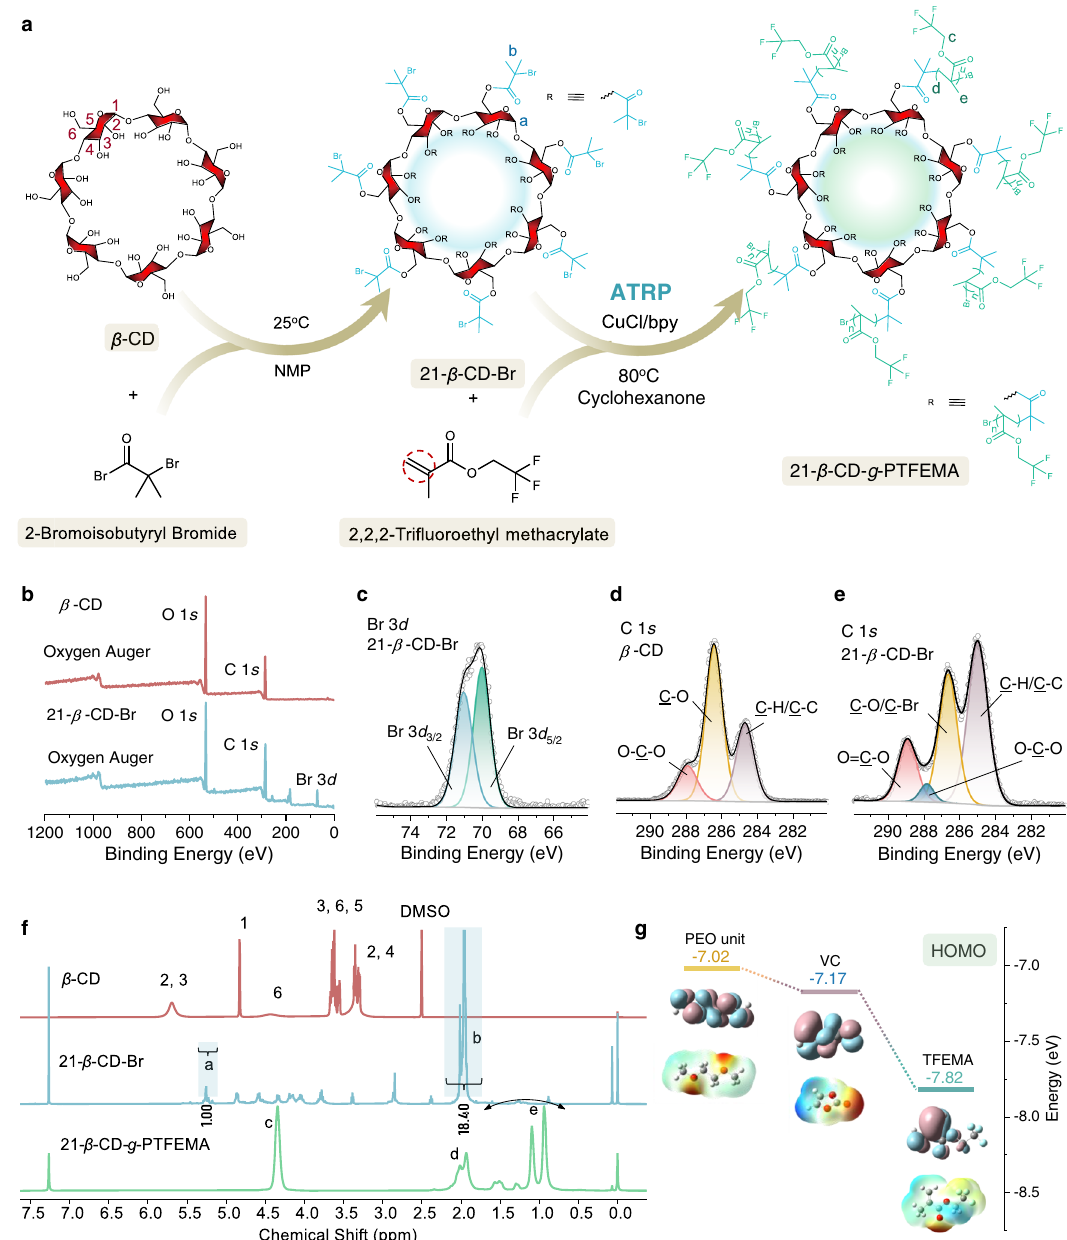
Fig. 1 Synthetic route for 21-arm fl uoropolymers (21- β -CD- g -PTFEMA) and corresponding physicochemical and theoretical characterizations. a Detailed synthetic scheme of 21- β -CD- g -PTFEMA. b – e X-ray photoelectron spectroscopy (XPS) results of β -CD and heptakis [2,3,6-tri- O -(2-bromo-2- methylpropionyl]- β -cyclodextrin (21- β -CD-Br): b full spectra of β -CD and 21- β -CD-Br, c Br 3 d core level spectrum of 21- β -CD-Br, d C 1 s core level spectrum of β -CD, and e C 1 s core level spectrum of 21- β -CD-Br. f 1 H nuclear magnetic resonance ( 1 H NMR) spectra of β -CD, 21- β -CD-Br, and 21- β -CD- g -PTFEMA. g Density functional theory (DFT) analysis of the highest occupied molecular orbital (HOMO) and probability of electron cloud density distributions for different polymer